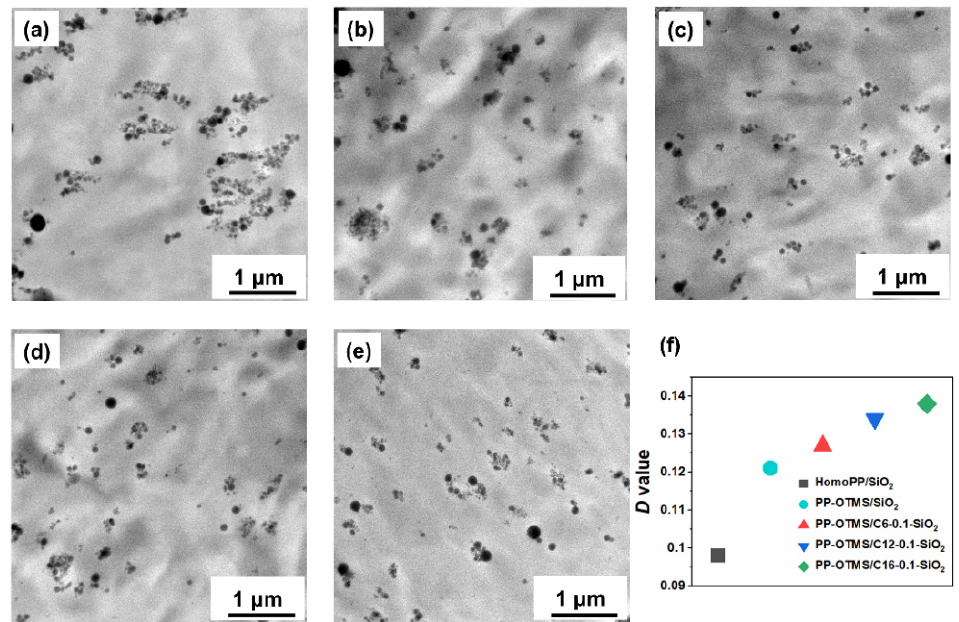
Figure 2. TEM images of nanocomposites: ( a ) HomoPP/SiO 2 , ( b ) PP-OTMS/SiO 2 , ( c ) PP-OTMS/C6- 0.1-SiO 2 , ( d ) PP-OTMS/C12-0.1-SiO 2 , and ( e ) PP-OTMS/C16-0.1-SiO 2 . The SiO 2 content was 5.0 wt%